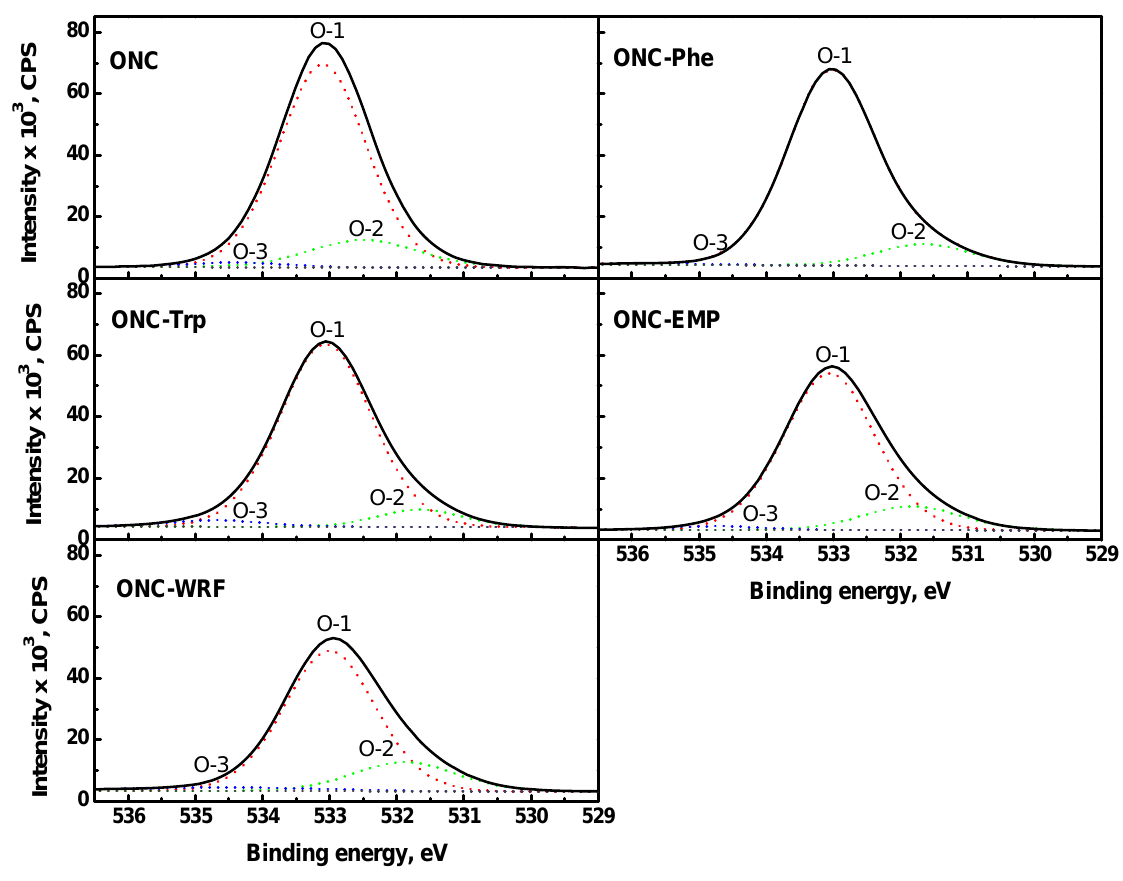
Figure 8. O 1s narrow scan XPS spectra for ONC, ONC-Phe, ONC-EMP, ONC-Trp and ONC-WRF.